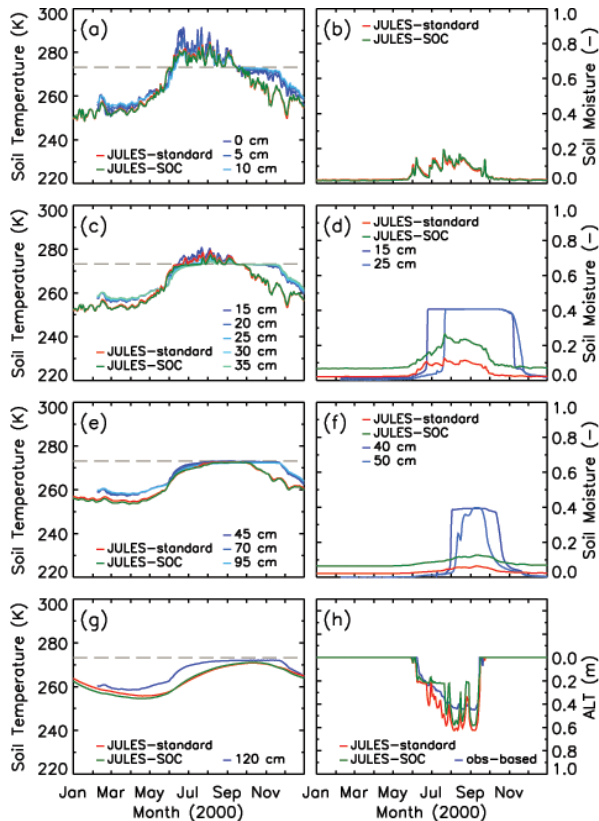
Fig. 8. Simulated soil temperature (a, c, e, g) , soil moisture con- tent (b, d, f) and thaw depth (h) at Atqasuk, Alaska in 2000 with standard and adjusted (SOC) soil parameters compared with obser- vations: (a, b) top model layer (0–10cm); (c, d) second layer (10– 35cm); (e, f) third layer (35–100cm); (g) bottom model layer (1.0– 3.0 m); (h) active layer thickness calculated from soil temperature profiles. Observations are indicated by their depth of measurement, soil moisture content is fraction of total